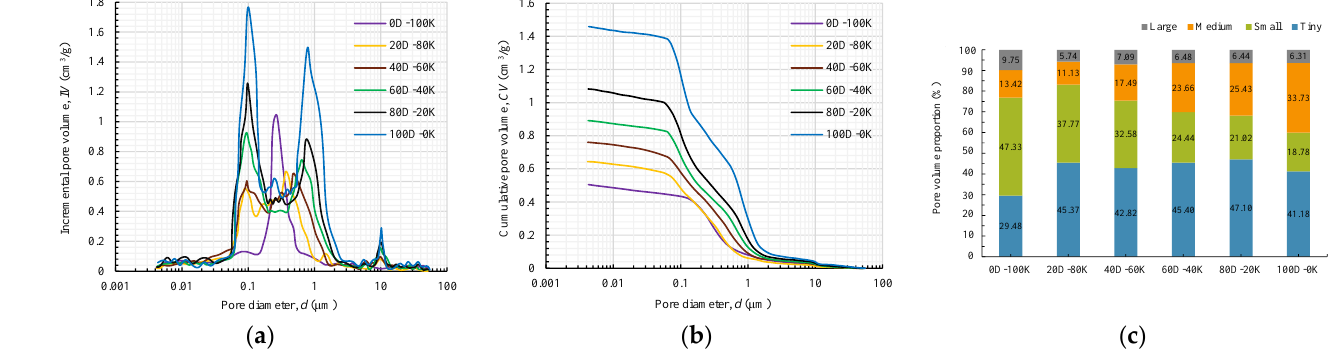
Figure 5. Results of mercury intrusion porosimetry tests on DKM samples: ( a ) IV – d curves; ( b ) CV – d curves; ( c ) volume proportion of pores with different diameters.